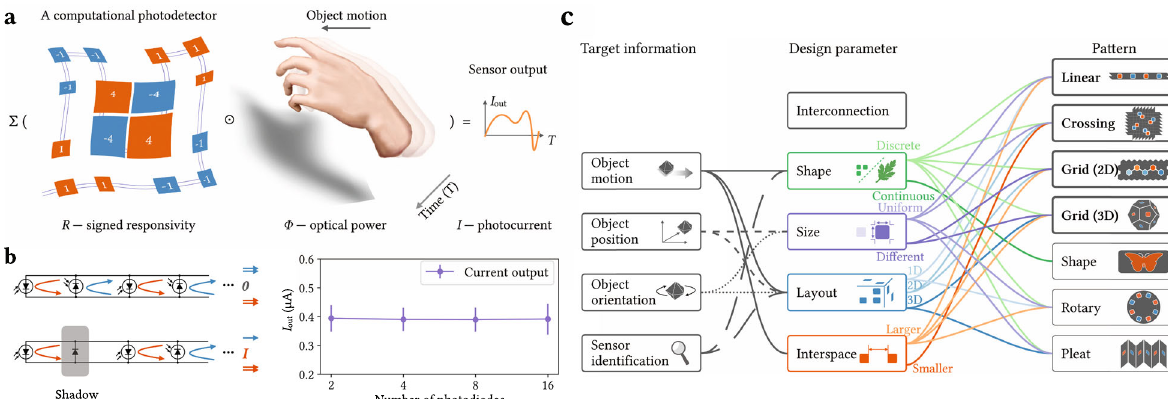
Fig. 1 Principle and design. a Computational photodetector with a pattern design produces a motion-incited output photocurrent, which corresponds to the convolution between the signed heterogeneous responsivity distribution and the incident optical power along the time axis. b The equivalent circuit of a typical computational photodetector without or with one photodiode blocked, and the corresponding current output (mean and standard deviation) versus the number of photodiodes connected in parallel with a single photodiode blocked at any given time. c Design space of a computational photodetector, which connects the target information, to relevant design parameters, and fi nally the pattern design. In this work, we demonstrate and evaluate the linear, crossing, and grid patterns as